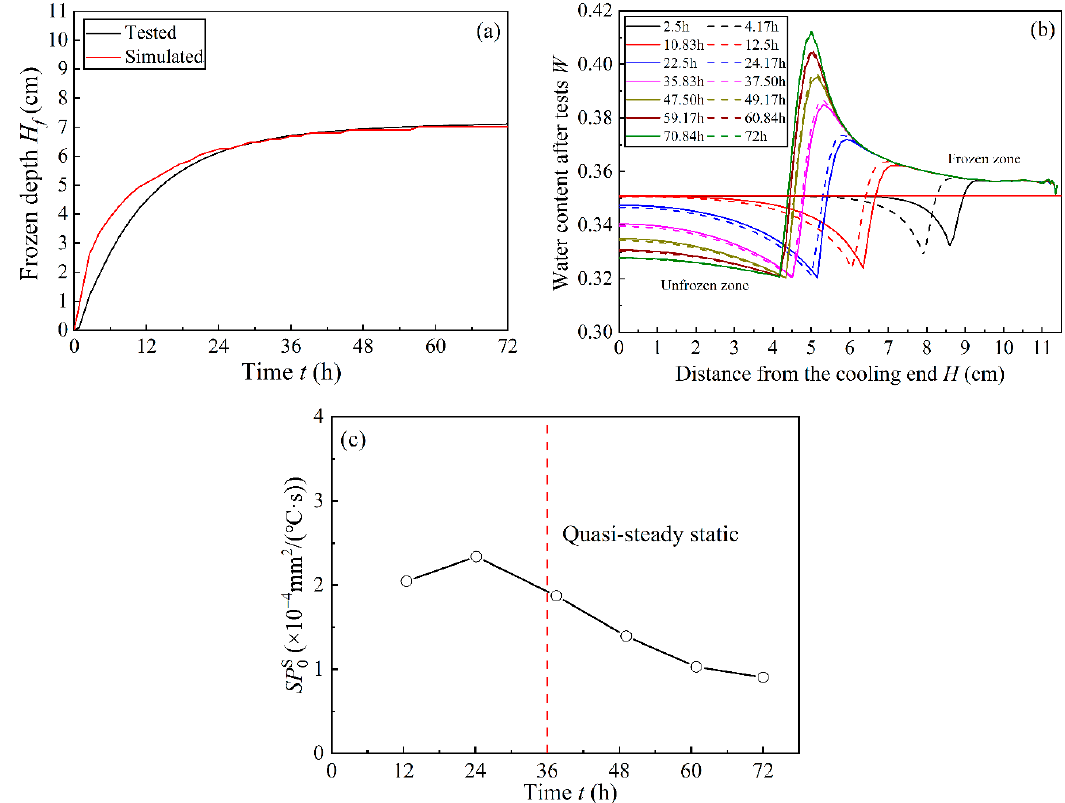
Figure 8. ( a ) Comparison of simulated and measured frozen depth under no load, ( b ) profile of water redistribution of the soil samples at different freezing times under no load, ( c ) variation of the segregation potential with the freezing time.